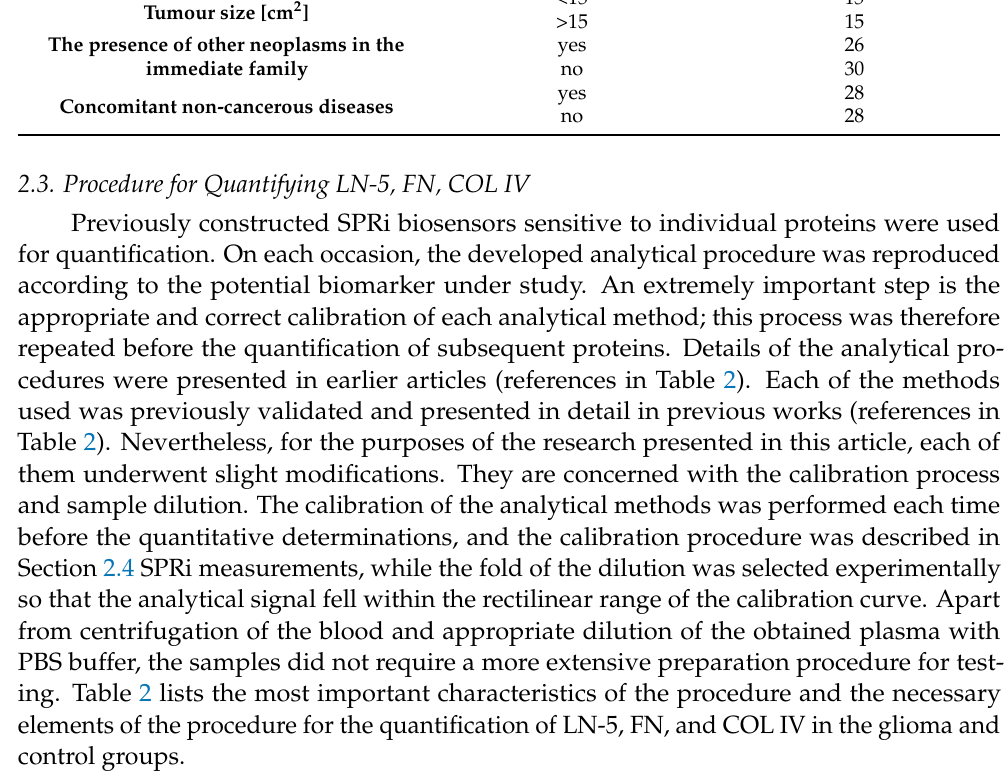
Table 2. Characteristics of analytical methods and procedures for quantifying the concentration of tested